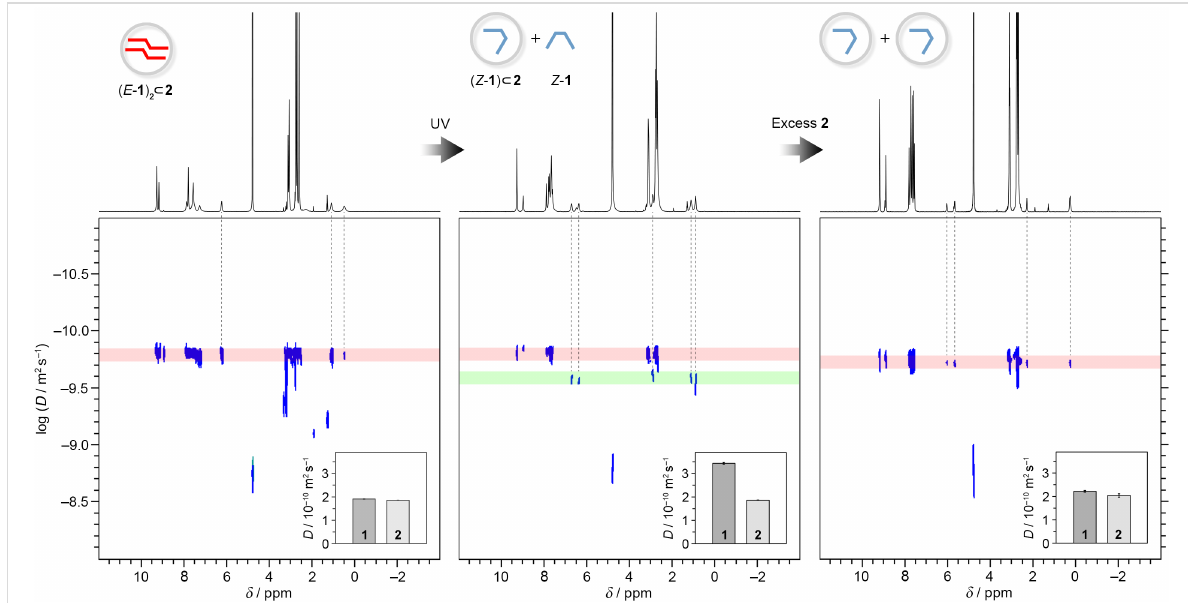
Figure 7: 1 H NMR and 1 H DOSY spectra of ( E - 1 ) 2 2 (500 MHz, D 2 O, 298 K) before (left) and after (center) UV irradiation and after the addition of ~2.5 equiv of 2 (right). The vertical dashed lines denote the resonances of 1 ’s protons.